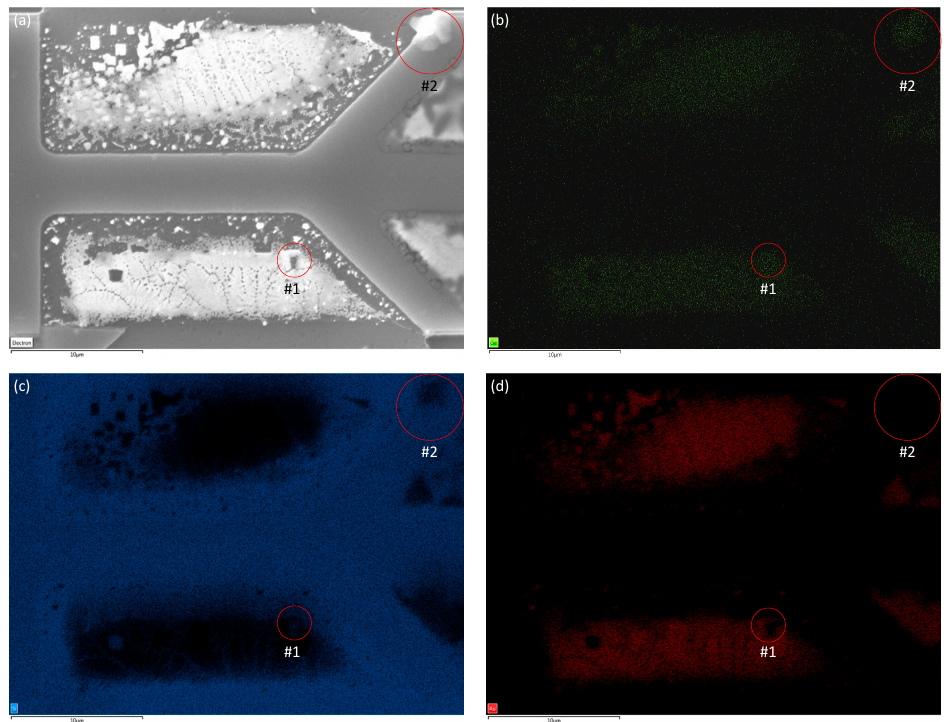
Figure 10. ( a ) Plan-view SEM micrograph of two neighboring large-opening micro-crucibles and the corresponding EDS maps of ( b ) Ge, ( c ) Si, and ( d ) Au.